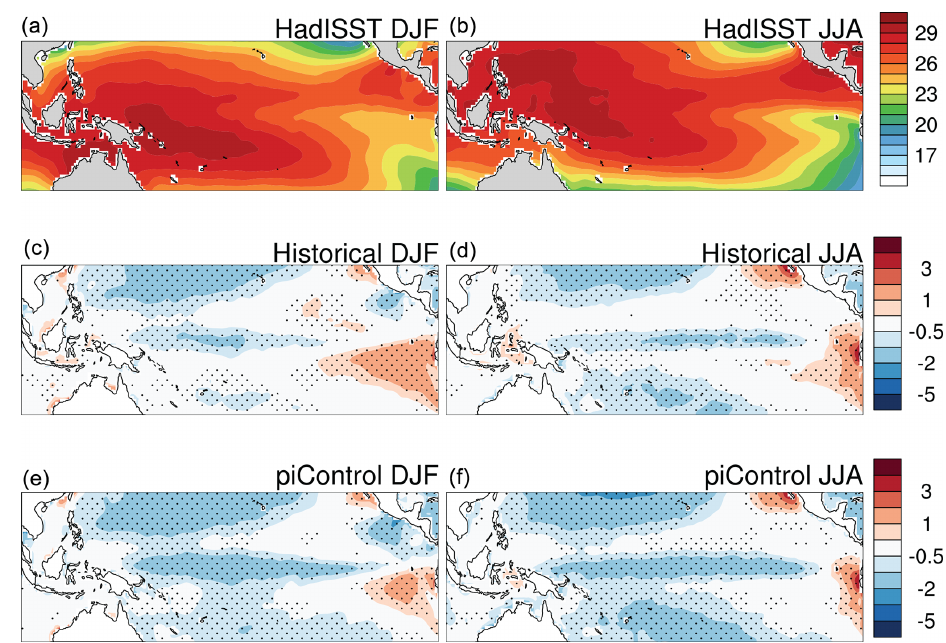
Figure 1. Ability of the ensemble to simulate present-day sea surface temperature (SST) patterns: (a) DJF and (b) JJA SST climatology from HadISST observational dataset (Rayner et al., 2003) between 1971 and 2000, (c) DJF and (d) JJA model ensemble mean SST in historical simulations minus HadISST observations between 1971 and 2000, and (e) DJF and (f) JJA model ensemble mean SST in pre-industrial control simulations minus HadISST observations. Units are ◦ C. Stippling indicates that more than two-thirds of the ensemble members agree on the sign of the anomaly.